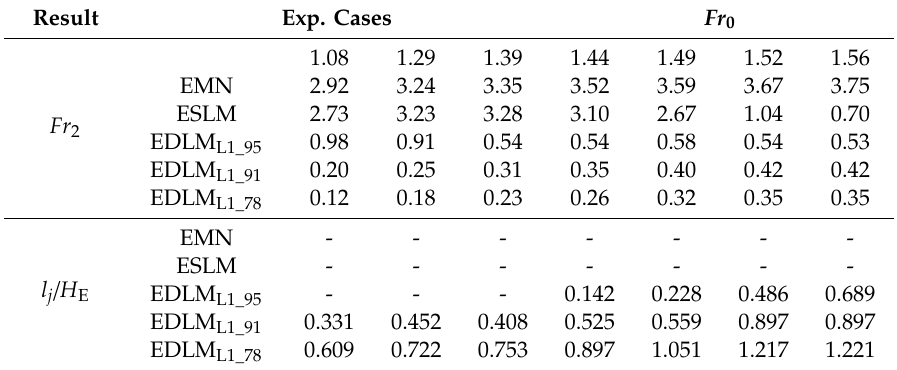
Table 2. Flow condition in the defense system and hydraulic jump position on the embankment slope. Result Exp.